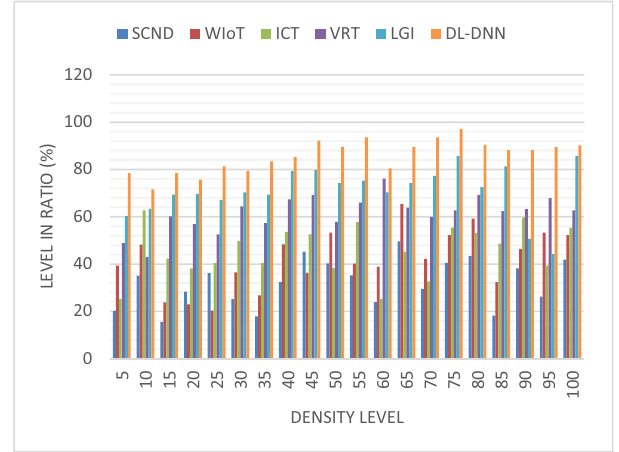
Figure 8: Landscape - level